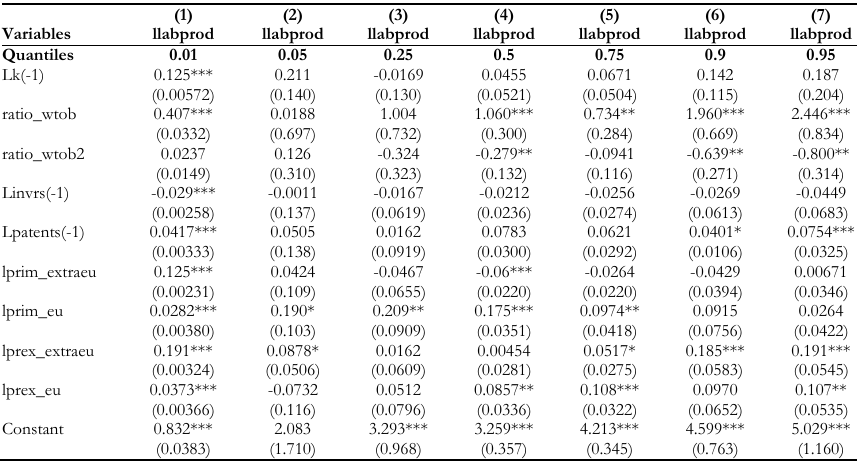
Quantile Regression Results for selected sectors: Food